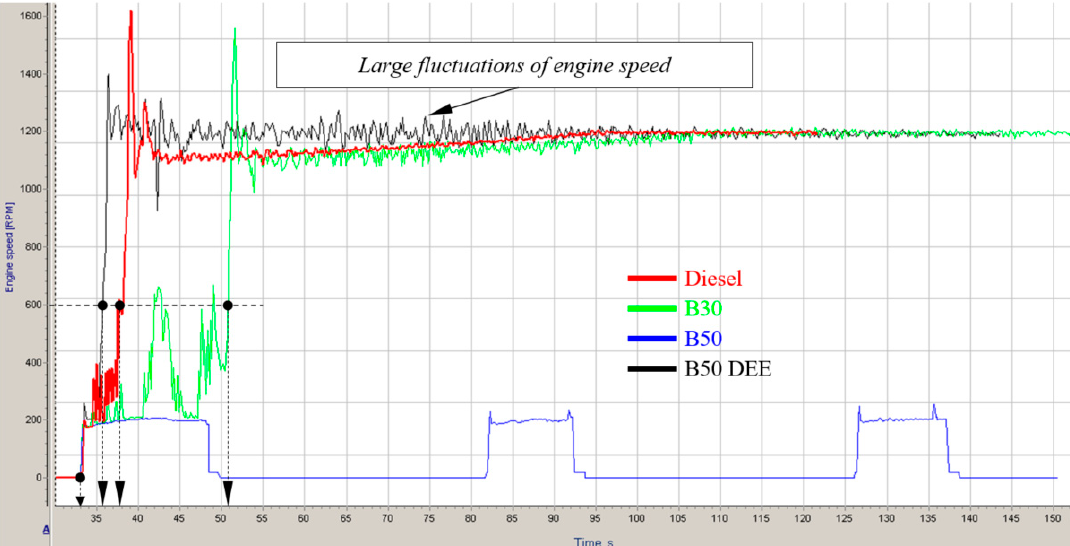
Figure 4. Engine speed evolution.